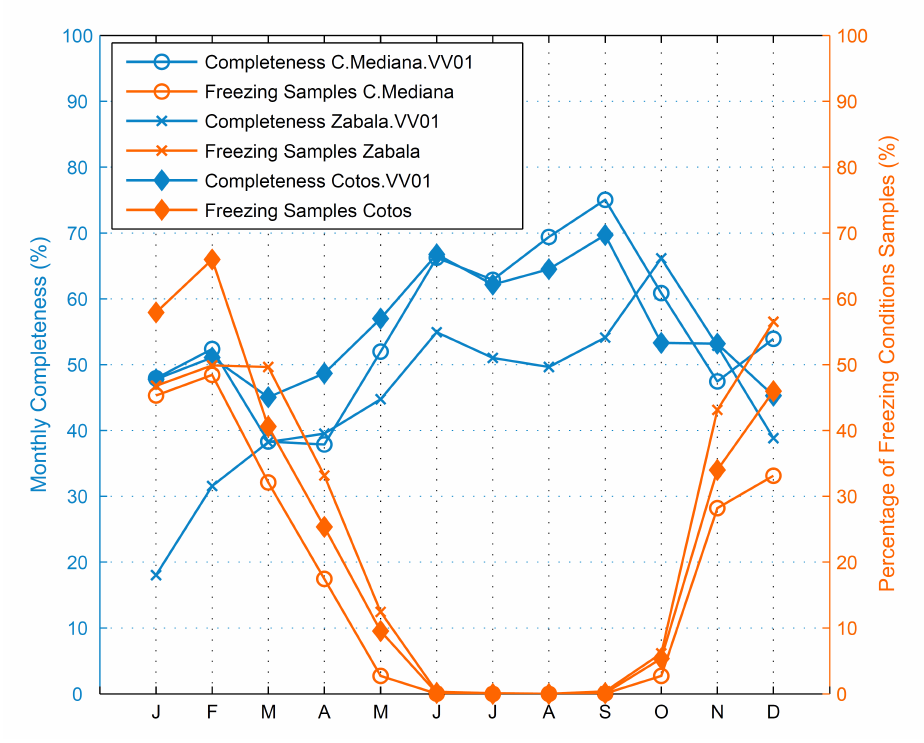
Figure 8. Data completeness (blue) for three sites and percentage of wind speed measurements taken under freezing conditions (orange).